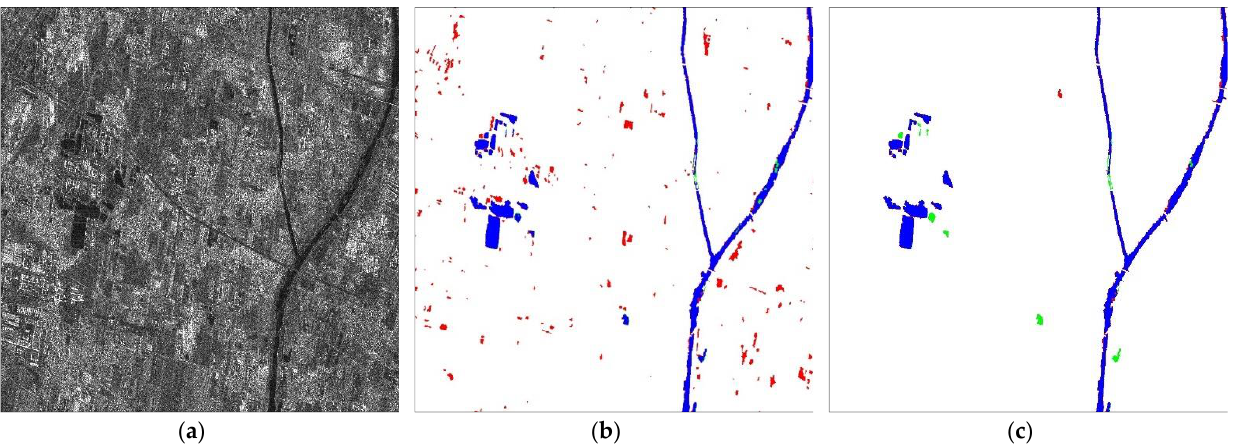
Figure 9. The results classified without and with postprocessing in Data B. ( a ): SAR image, ( b ): result without postprocessing, and ( c ): result with postprocessing.